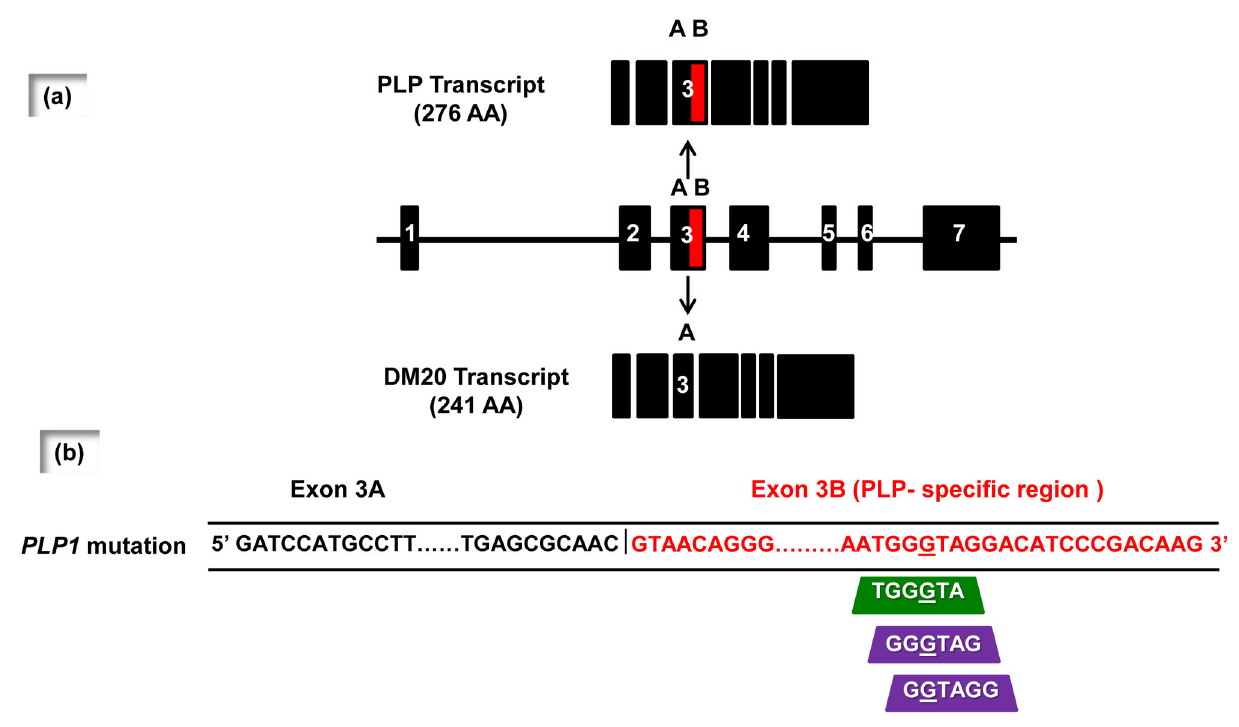
Figure 1. Schematic representation of the analysis of PLP1 gene structure with the ESEfinder, Human Splicing Finder and FAS-ESS programs. (a) Schematic representation of PLP1 gene structure (7 exons) and the alternative splicing of the PLP1 gene into the major PLP1 transcript and a minor transcript encoding the shorter DM20 isoform, which differs only in terms of the latter half of exon 3 (3B) which is post-transcriptionally spliced out. (b) Only part of the sequence of exon 3A (sequence in black type) and exon 3B (sequence in red type) mutant PLP1 transcript is represented. The mutated nucleotide (c.436C>G) is underlined. According to the ESEfinder 3.0 program, the c.436C>G change created an exonic splicing enhancer (EES, green trapezium), whereas Human Splicing Finder version 2.4.1 and FAS-ESS web server predicted the creation of two exonic splicing silencers (ESS, purple